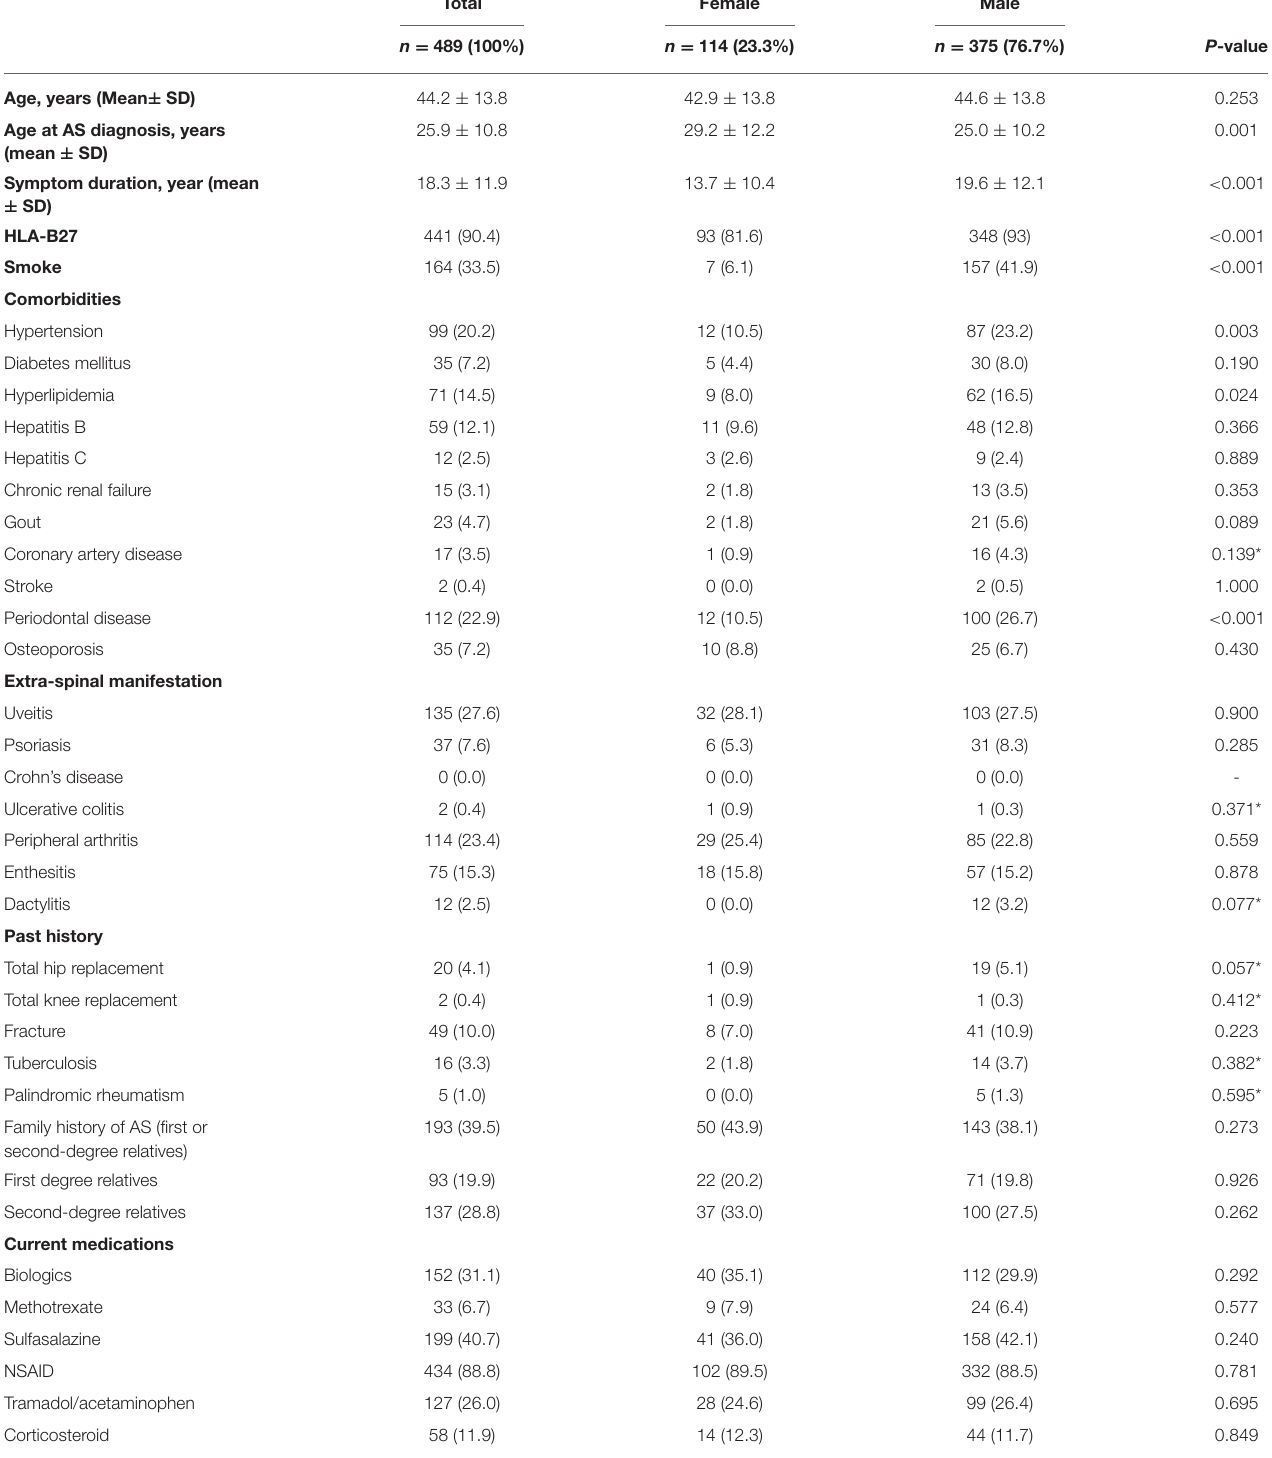
TABLE 1 | Demographic data and clinical characteristics at presentation of patients with AS. Total Female Male n = 489 (100%) n = 114